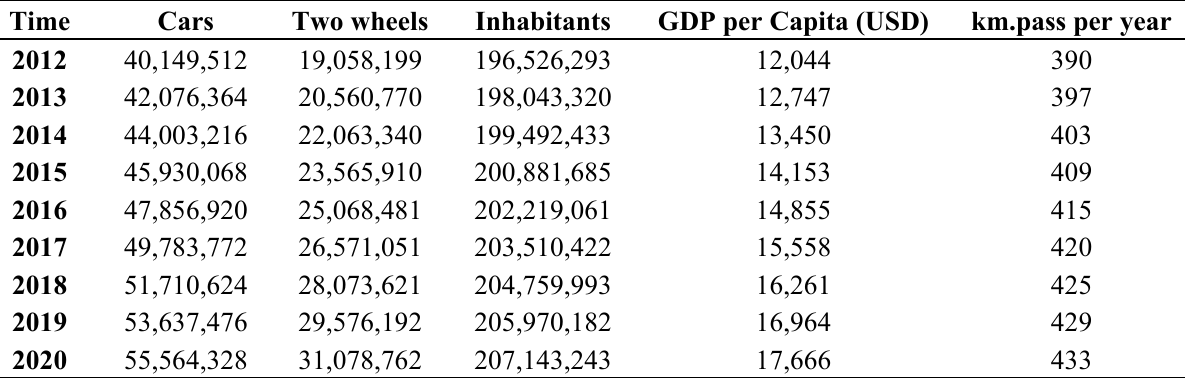
Table A5 and Figure A1 present the forecasts for PKM demand. Table A5. PKM Demand forecasts.